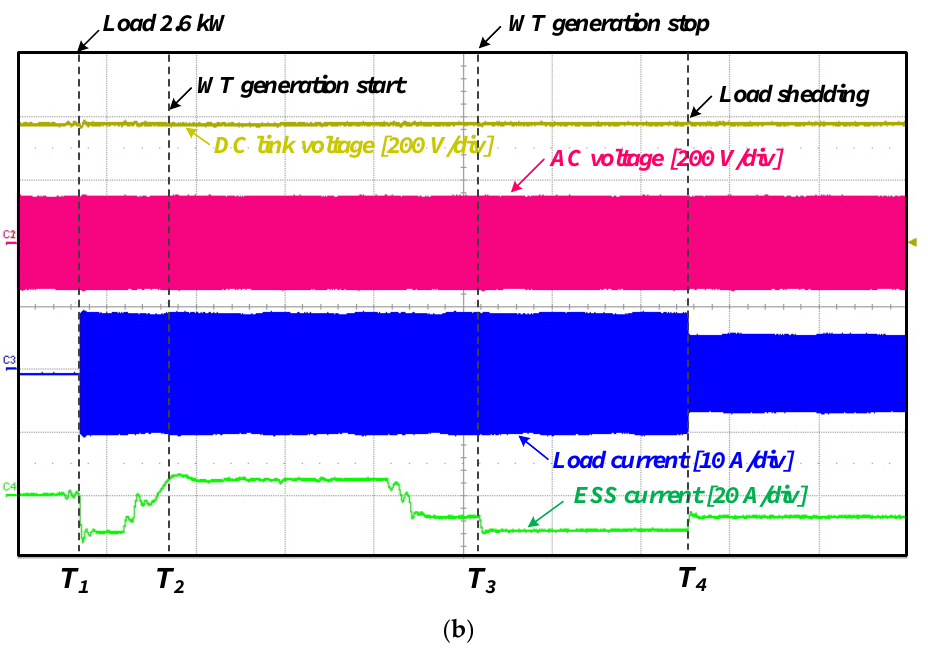
Figure 25. Experiment waveforms of operation mode 6 ( a ) Power quantity of major parts and SOC, ( b ) Voltage and current waveforms in major parts. Table 9. Power flow of each power converter in operation mode 6.